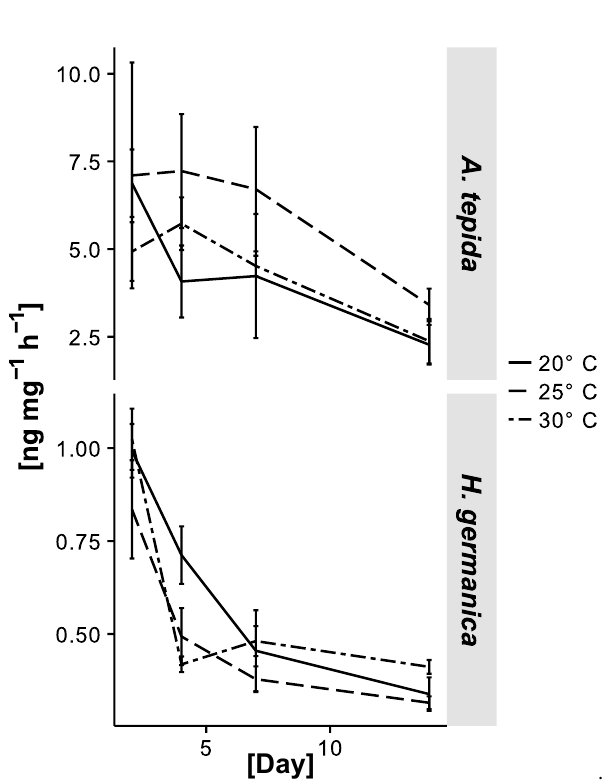
Figure 5. Nitrogen uptake rates. Uptake rates of phytodetrital nitro- gen by A. tepida and H.germanica at 20, 25 and 30 ◦ C. Error bars denote standard